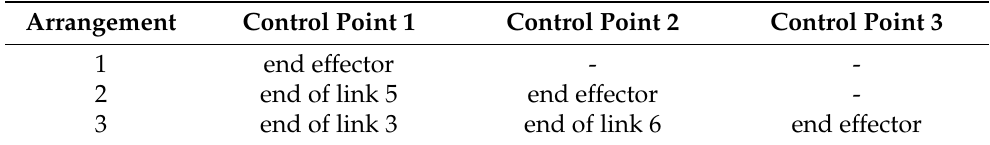
Table 3. Control points